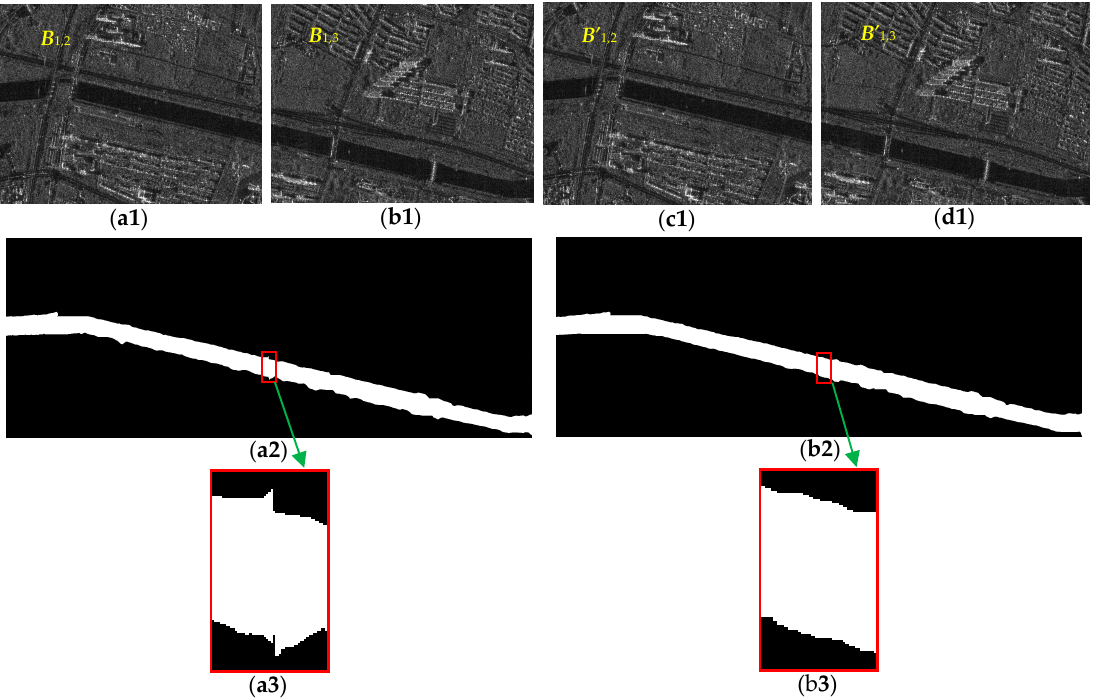
Figure 11. Example of stitching non-overlapping and overlapping sub-image block extraction results. ( a1 )–( d1 ) Original sub-image blocks. ( a2 )–( b2 ) Stitching of extraction results of non-overlapping and overlapping partition. ( a3 )–( b3 ) Comparison of partial enlargement near the stitching